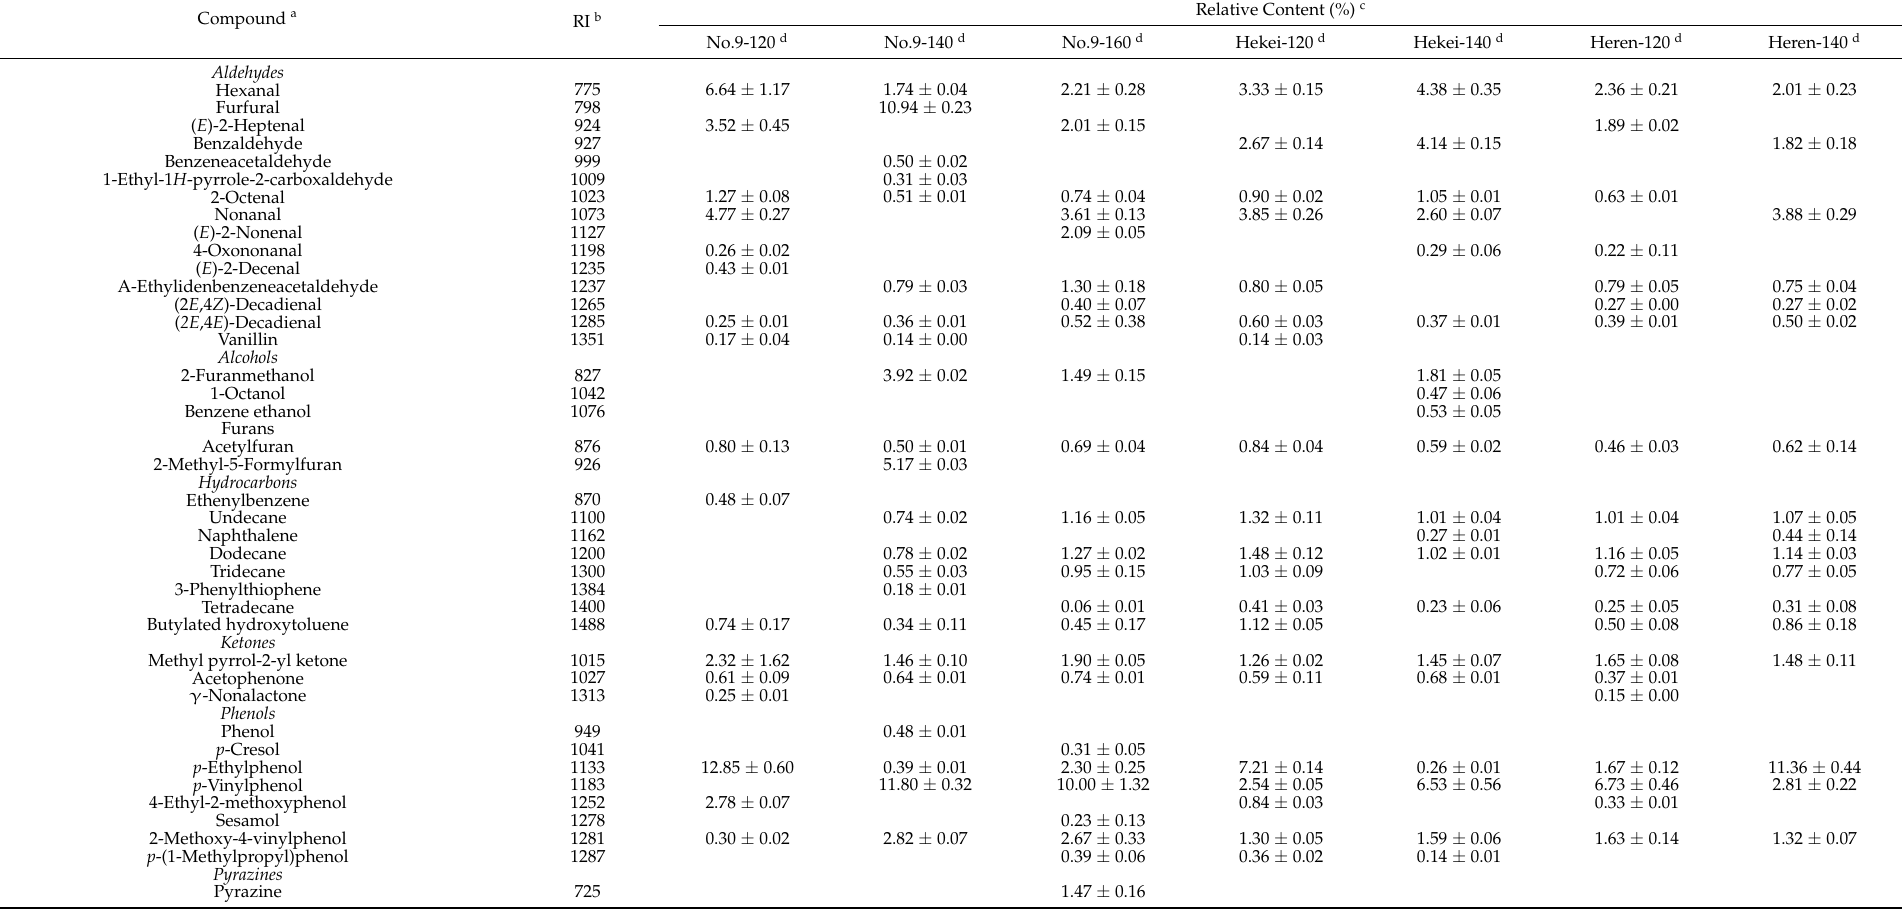
Table 1. Comparisons of compounds obtained in response to different roasting temperatures for Tainan S. No. 16 and Tainan S. No. 9. Compound